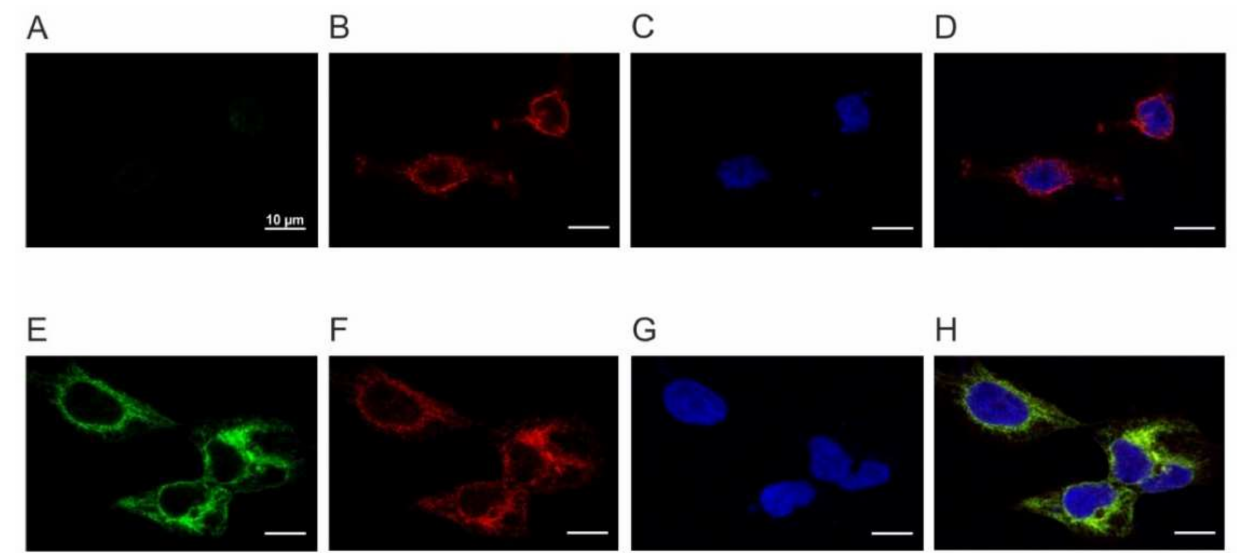
Figure 4. Confocal microscopy of flpTM and PaOct β 2R-HA-expressing flpTM cells. FlpTM ( A – D ) and PaOct β 2R-HA-expressing flpTM cells ( E – H ) were co-immunostained with rat anti-HA antibod- ies and specific antibodies against the CNG channel. ( A , E ) Samples were incubated with primary rat anti-HA antibodies (dilution 1:100) and secondary goat anti-rat-Alexa488 (dilution 1:500) anti- bodies. Non-transfected flpTM cells do not show fluorescent signals ( A ). In PaOct β 2R-expressing flpTM cells ( E ), the PaOct β 2R-HA protein was detected. ( B , F ) The same samples were incubated with specific antibodies directed against the C-terminus of the CNG channel (dilution 1:200) and secondary donkey anti-mouse-Cy3 (dilution 1:400) antibodies. In both cell lines, the CNG channel was detected. ( C , G ) Nuclei were stained with TOPRO-3 and are clearly differentiated from the cytosol. ( D , H ) Composite